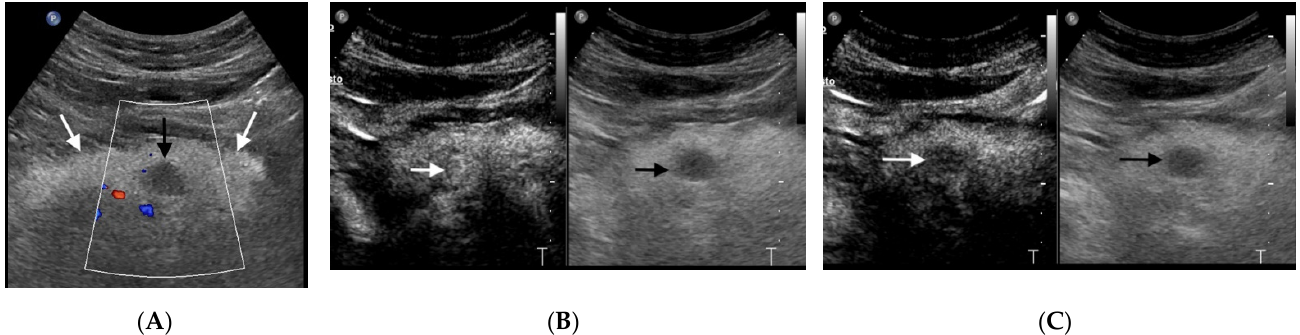
Figure 2. Pancreatic NET: insulinoma. ( A ) Color Doppler Ultrasonography (white box) depicts lack of vascularity within a 1.5 cm hypoechoic mass (black arrow) in the pancreatic body (white arrows). ( B ) On CEUS, in the arterial phase (19 s after the injection of c.a.), the mass is slightly hyperechoic in comparison with the adjacent pancreatic parenchyma (arrow), indicating rich vascularity. ( C ) On CEUS, in the late phase (120 s after the injection of c.a.), the mass is hypoechoic in comparison with the adjacent pancreatic parenchyma (arrow), indicating “wash-out”. Table 2. Features and enhancing pattern of focal pancreatic lesions in CEUS.